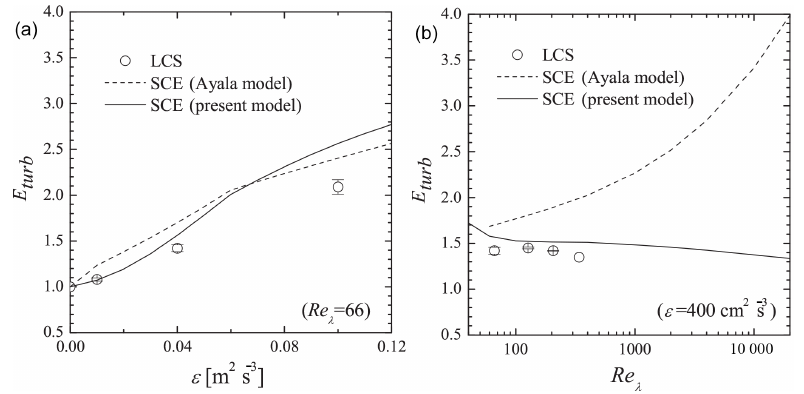
Figure 10. Turbulence enhancement factors for r c = 15 as a function of (a) the energy dissipation rate and (b) the Taylor-microscale- based Reynolds number Re λ . Re λ = 66 in (a) and (cid:15) = 400cm 2 s − 3 in (b) . The error bars indicate the standard deviations.